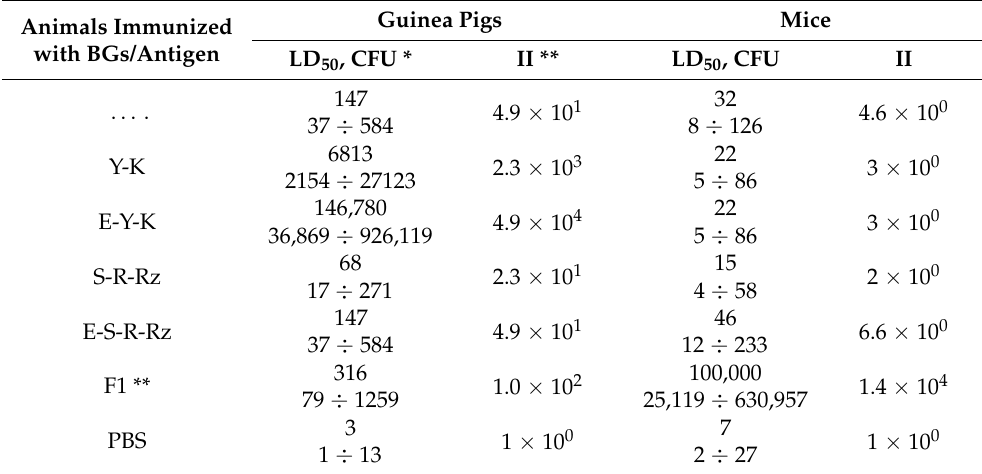
Table 3. Indices of immunity (II) induced by BGs